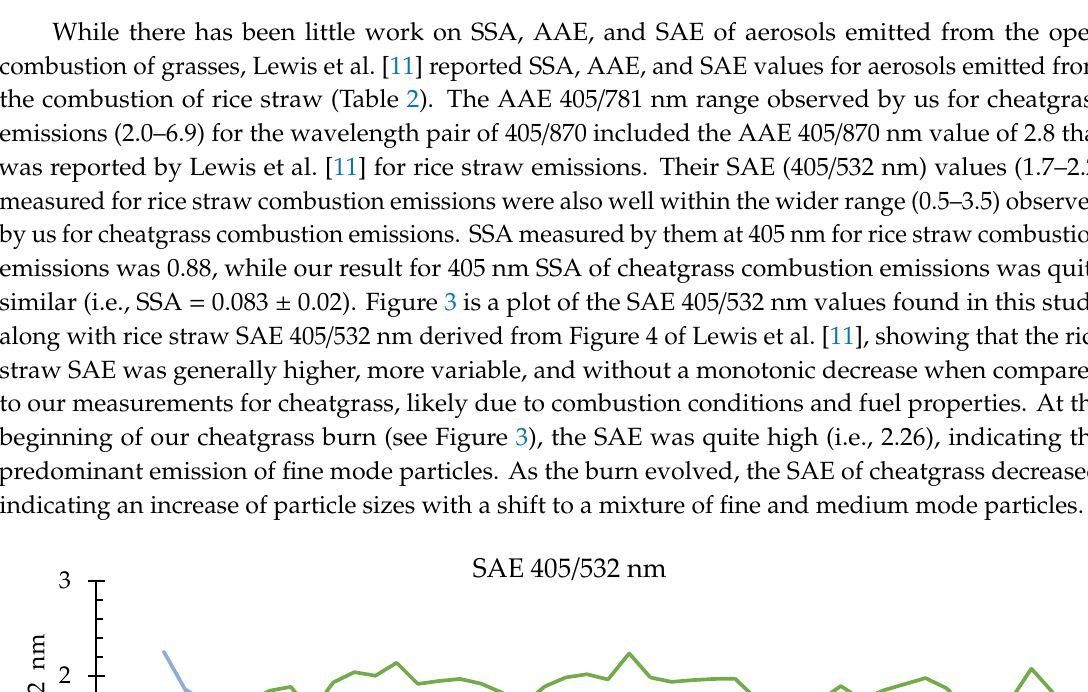
Table 2. The optical properties absorption Å ngström exponent (AAE), the scattering Å ngström exponent (SAE), and the single scattering albedo (SSA) of cheatgrass combustion emissions are listed, along with the optical properties (i.e., AAE, SAE, and SSA) of rice straw combustion emissions, as reported by Lewis et al. [11].